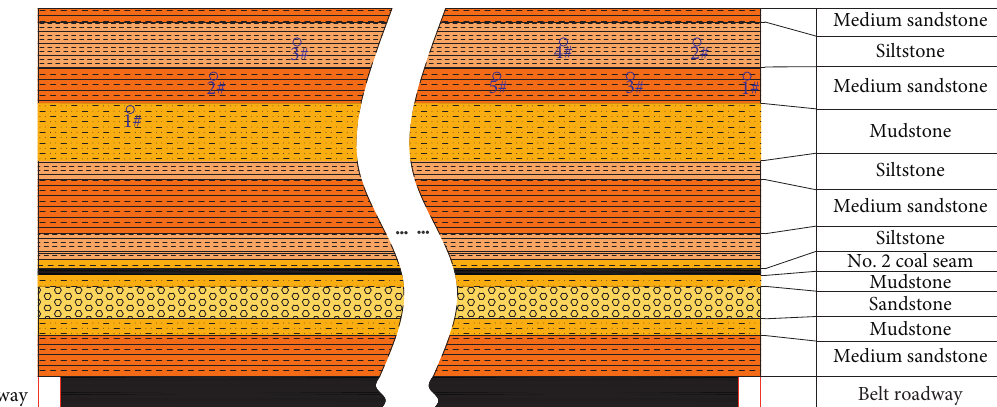
Track roadway Belt Figure 16: Schematic diagram of long-hole directional drilling in the fracture zone in overlying strata of the 4305 rear working